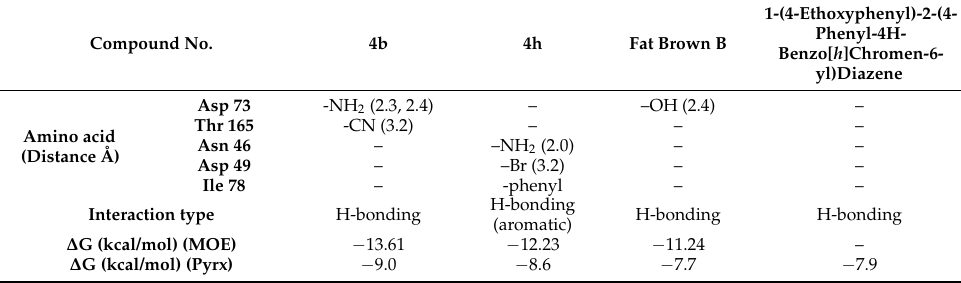
Table 5. Description of the docking data of the selected target compounds.